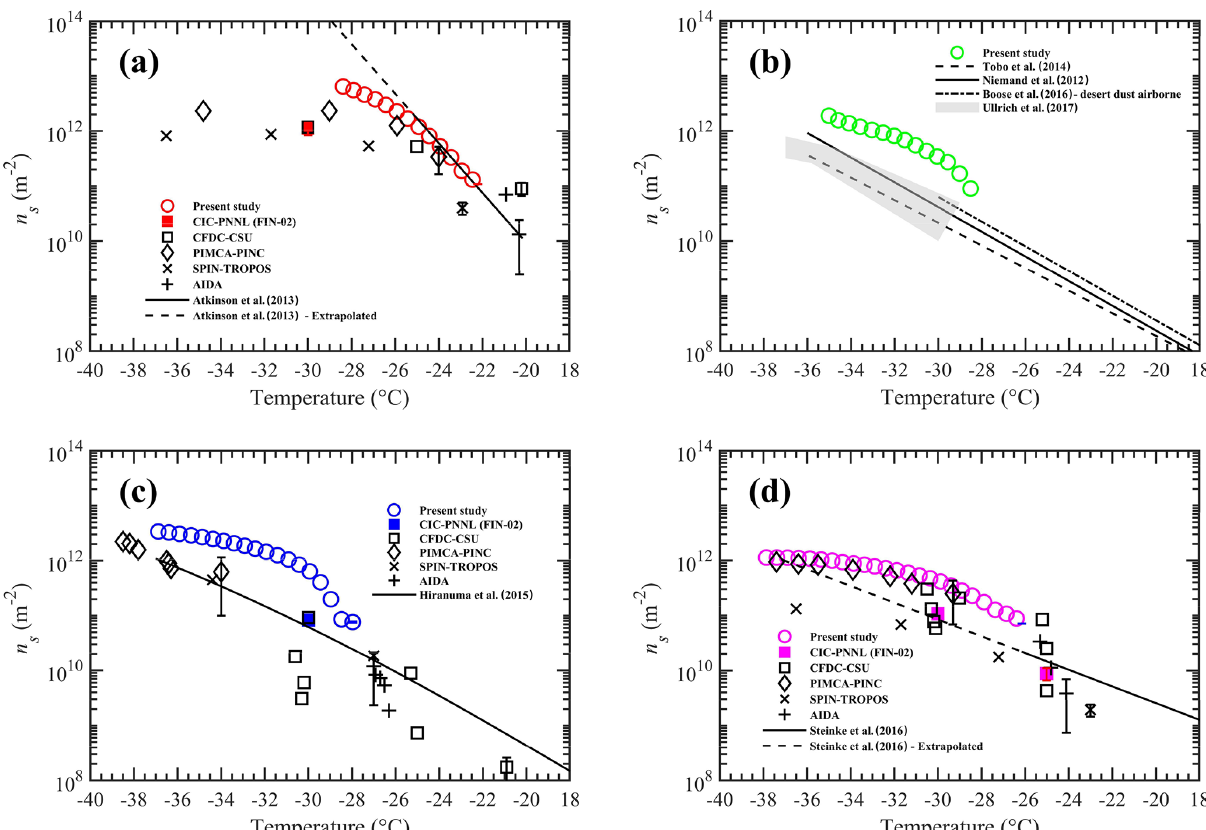
Figure 7. Ice nucleation active site density ( n s ) as a function of temperature for four INP test species tested in this study. The panels (a) to (d) show n s densities for K-feldspar, airborne arable dust, illite-NX, and Argentinian soil dust, respectively. Solid and dash-dotted lines represent various parameterizations from the literature. See the text for details. Dashed lines in panels (a) and (d) indicate the extrapolated data calculated outside the temperature limits recommended in these n s parameterizations. The black color symbols represent n s values from various other instruments that participated in FIN-02 activity (DeMott et al., 2018). Filled color symbols show the data from the CIC-PNNL chamber but operated at steady-state temperature and RH w = 106% conditions at FIN-02. For clarity, confidence intervals are shown only for one data point from each